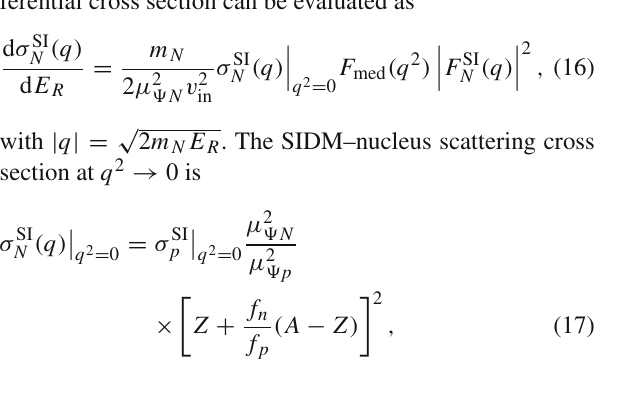
v (cid:11) /( (cid:10) v (cid:11) m (cid:3) ) (cid:3) 0.1–0.3 cm 2 /g at cluster scale. Additionally, the (cid:10) σ T r r upperlimitof (cid:10) σv r (cid:11) /( (cid:10) v r (cid:11) m (cid:3) ) isalsoconstrainedbythelowerboundof φ mass m φ (cid:4) 20 MeV. The points are the inferred values of (cid:10) σ from dwarfs (red), low surface brightness galaxies (blue) and clusters (green) [37]. The dashed lines from top left to bottom right are for the case of constant σ T / m (cid:3) with σ T / m (cid:3) = 100, 10, 1, 0.3, 0.1 and 0.01 cm 2 /g, respectively